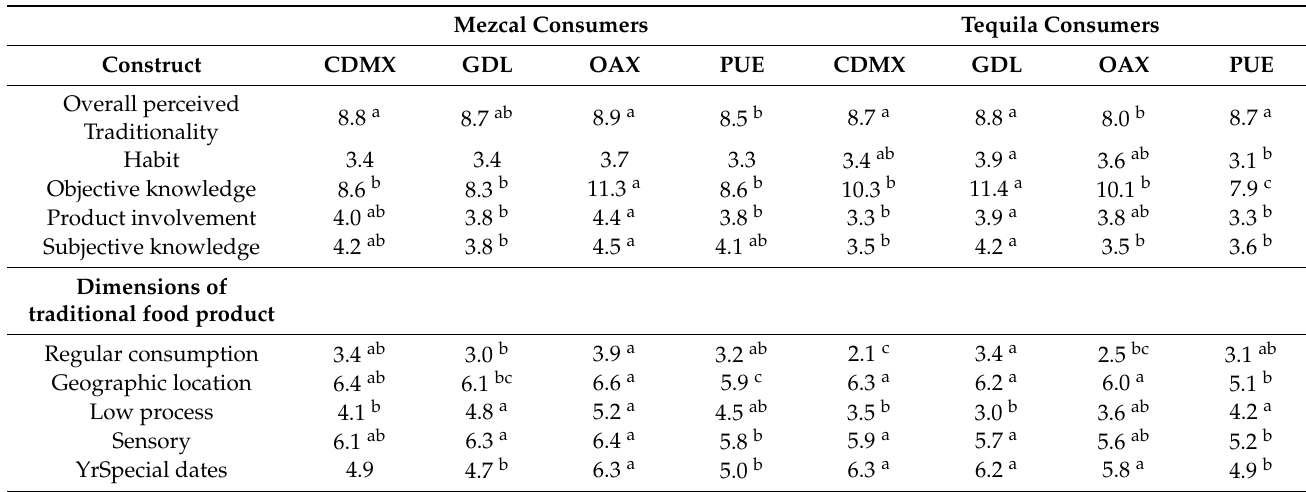
Table 3. Mean values for each construct and traditional dimension per location and